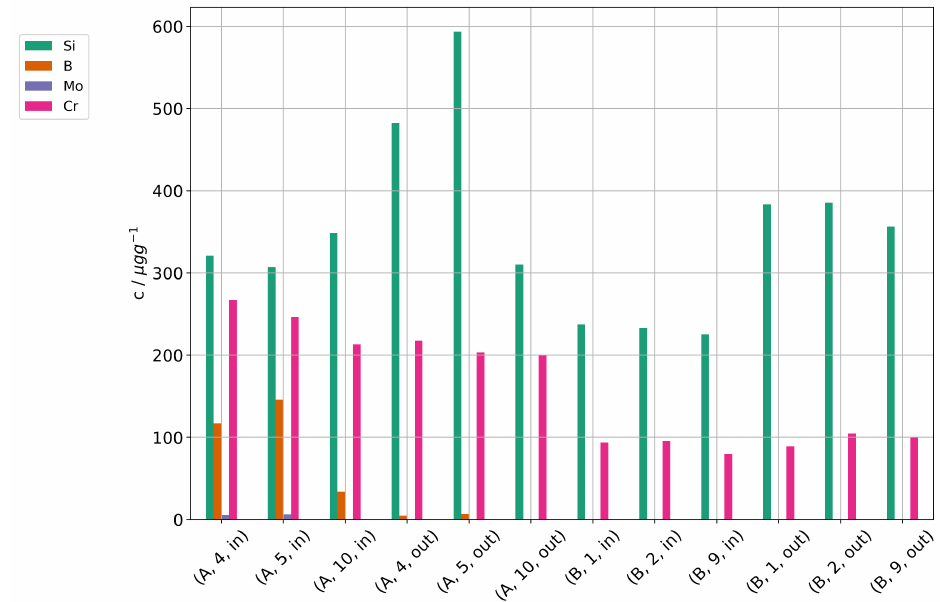
Figure 16. Concentrations of silicon, boron, molybdenum, and chromium found in cell samples of the stacks A and B after